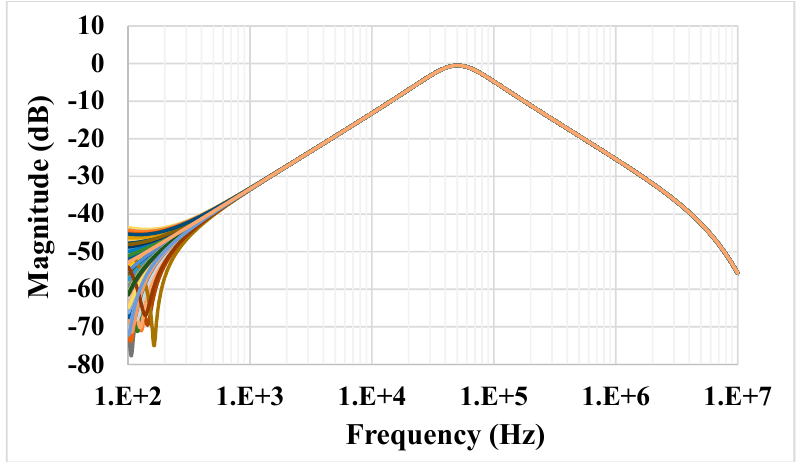
Figure 13. Monte Carlo analysis of the frequency characteristics of the BP filter with 200 runs.